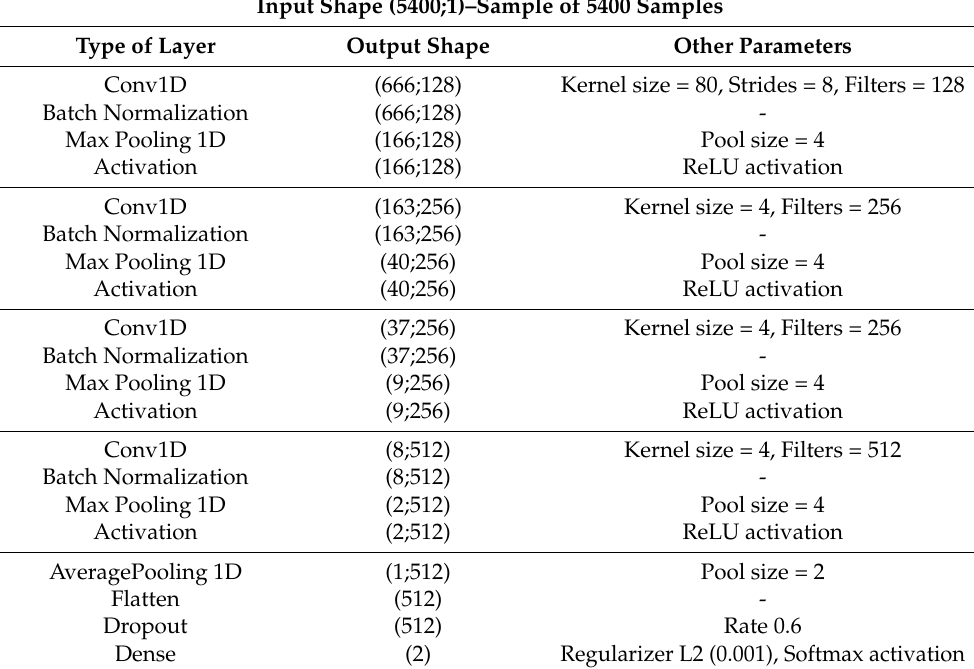
Table 4. Detailed parameters of the proposed 1D-CNN